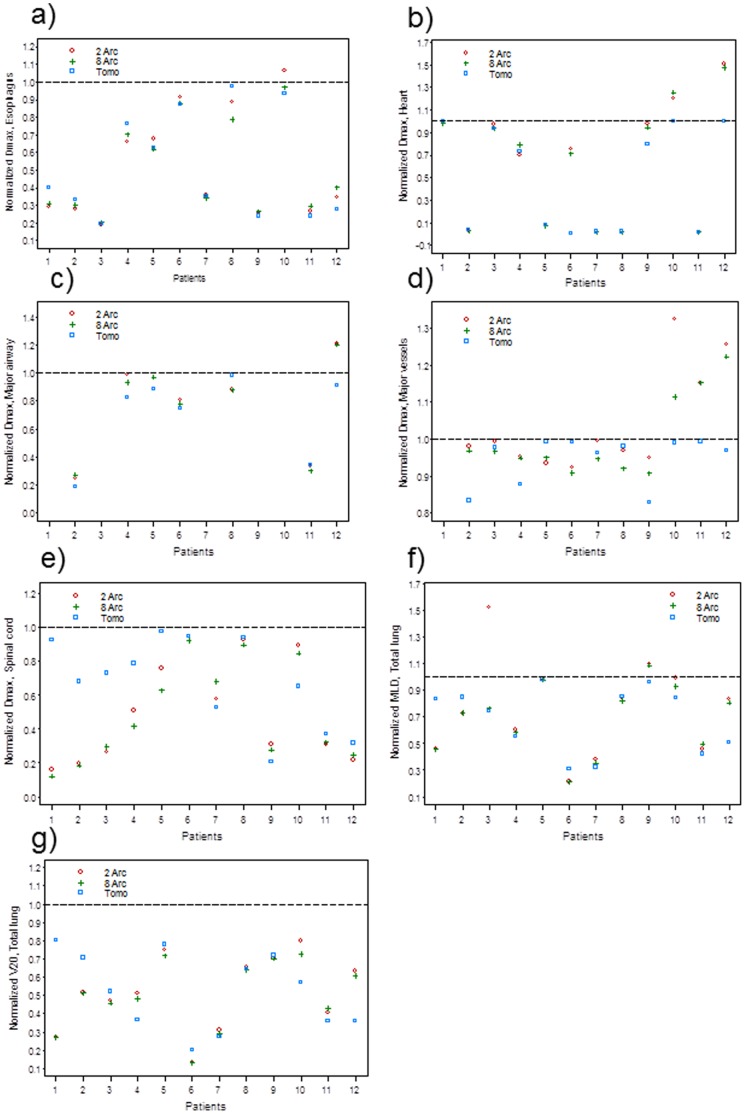
Comparison of dose parameters to the organs at risk.Organs at risk: a) Esophagus, b) heart, c) major airway, d) major vessels, e) spinal cord, f) and g) mean lung dose (MLD) and V20 for the total lung, after normalized to the absolute dose constraints between helical tomotherapy (Tomo), 2-arc, and 8-arc VMAT plans.